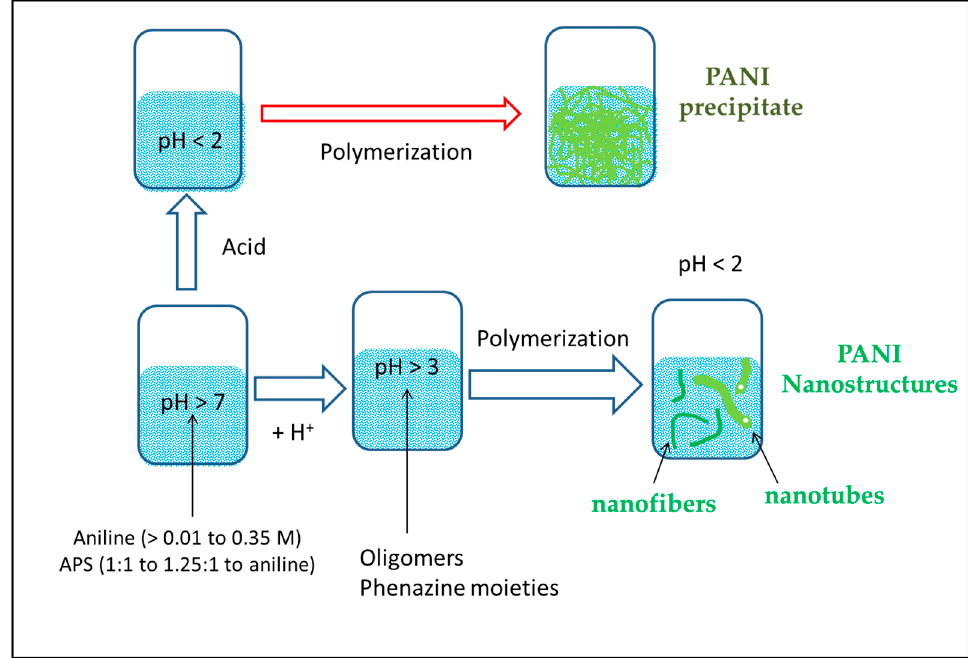
Scheme 4. Reaction steps underlying the pH-Dependent Polymerization (pHDP)